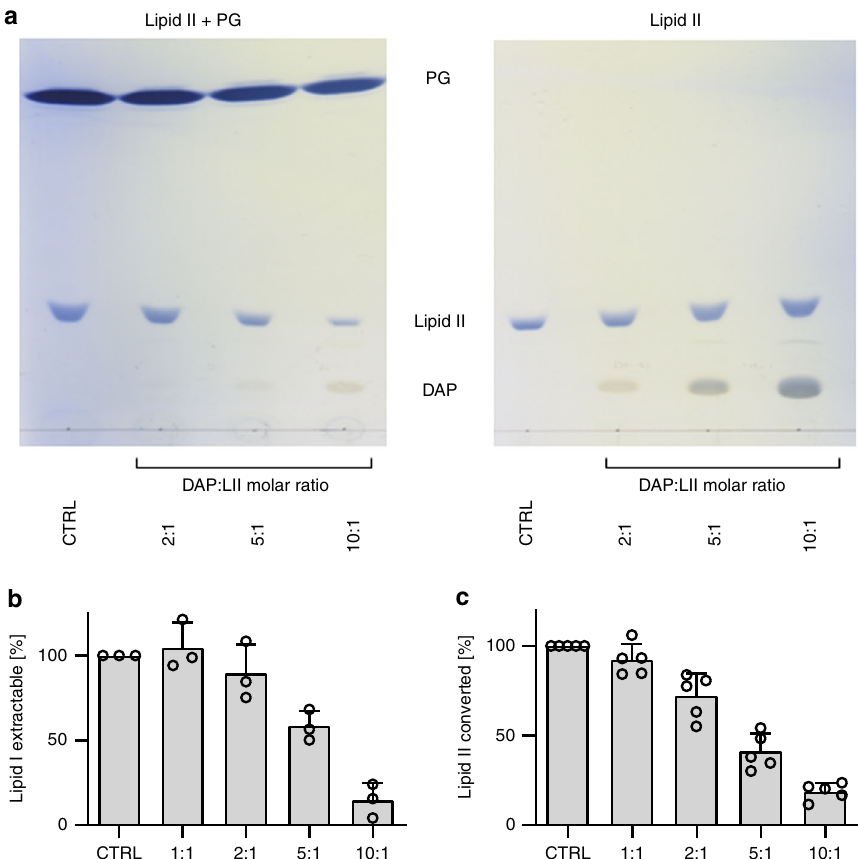
Fig. 5 DAP forms a tripartite complex with lipid II and PG and inhibits cell wall biosynthesis in vitro. a DAP was incubated with puri fi ed lipid II at increasing molar ratio in the presence (left TLC) and absence (right TLC) of PG. Reaction mixtures were extracted with BuOH and the upper solvent phase was spotted to TLC. Free PG, DAP and lipid II migrate to de fi ned positions on the TLC, while components that are locked in complex are retained in the lower aqueous phase after extraction and as a result are diminished on the TLC. Representative images from fi ve independent experiments are shown. b Impact of DAP on the MraY-catalysed synthesis of lipid I and c on the transglycosylation reaction catalysed by PBP2. DAP inhibits both reactions in a dose-dependent manner and almost completely blocks enzymatic activity when added in 10-fold molar excess. The enzymatic activity is expressed as synthesised lipid I (MraY) or converted lipid II (PBP2). The control reactions in the absence of antibiotics were set to 100%. DAP was added at molar ratios of 1:1 to 10:1 with respect to the lipid substrates as indicated. Data presented are means from three independent experiments and error bars represent the SD. Source data are provided as a Source Data fi